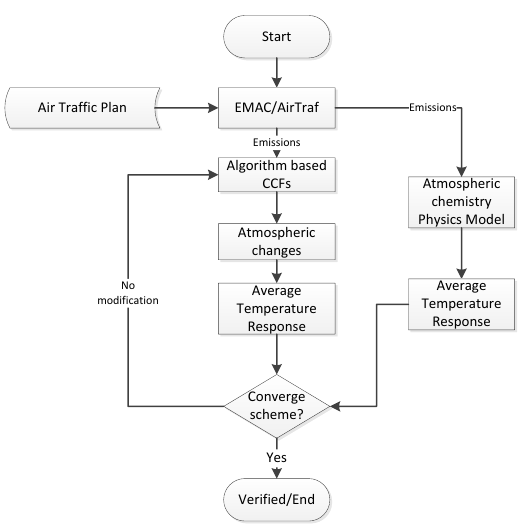
Figure 3. The aECFs verification procedure comparing climate impact metrics (ATR) calculated with two independent